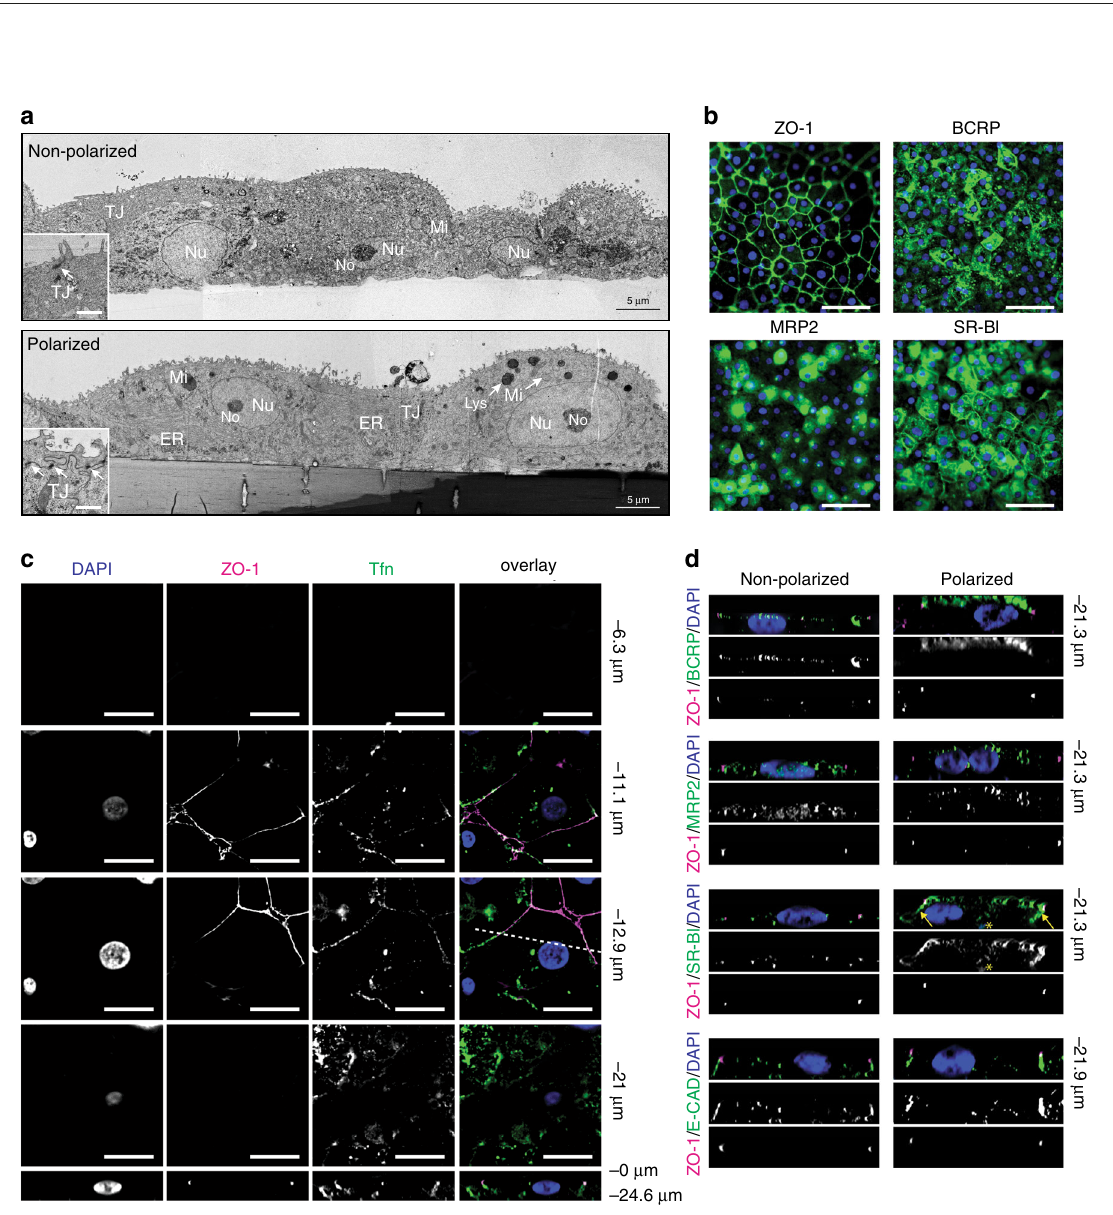
Fig. 1 Stem cell-based differentiation on transwells to generate polarized hepatocyte-like cells (pol-HLCs). a Schematic depicting the cellular organization of non-polarized, columnar polarized, and hepatocyte/multi-polarized cells. Blue boxes are tight junctions separating apical and basal membranes. b Stem cell differentiation protocol on transwells to generate pol-HLCs. c Representative immuno fl uorescence images of hESCs (day 0), de fi nitive endoderm (day 5), hepatic progenitor (day 9 and 13), immature HLCs (day 16), and pol-HLCs (day 21). Cells were stained for immature hepatocyte markers AFP (green) and FoxA2 (magenta) or for mature hepatocyte markers ALB (green) and HNF4 α (magenta). Scale bars = 500 μ m/ 250 μ m. d – f RT-qPCR analysis of the indicated genes along the pol-HLC differentiation protocol relative to D0 ( n = biological replicates). g Pol-HLCs metabolize carboxy fl uorescein diacetate (CFDA) and indocyanine green (ICG), and store glycogen as evidenced by periodic acid-schiff staining (PAS) staining. Scale bars = 250 μ m h Paracellular permeability of polarized HLCs incubated O/N with 4 kDa FITC-dextran or 70 kDa RITC-dextran in the absence or presence of EDTA, plotted relative to diffusion across empty fi lters ( n = biological replicates). i Rate of albumin (left panel) and urea (right panel) secretion into either the top or bottom compartment during pol-HLC differentiation ( n = biological replicates). Statistical analysis was performed using a two-tailed unpaired t test with Bonferroni adjustment for multiple comparisons.